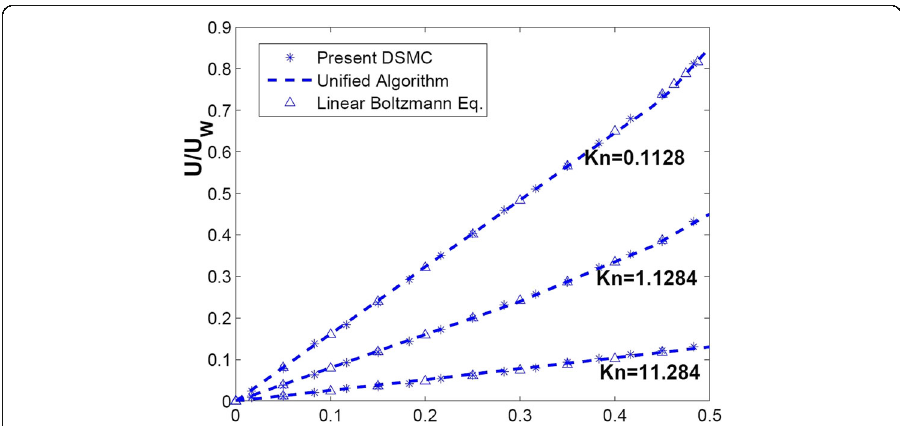
Fig. 3 Flow velocity distributions of the present DSMC under different Knudsen numbers for Couette flow with comparison of the GKUA and the solutions of the linear Boltzmann equation